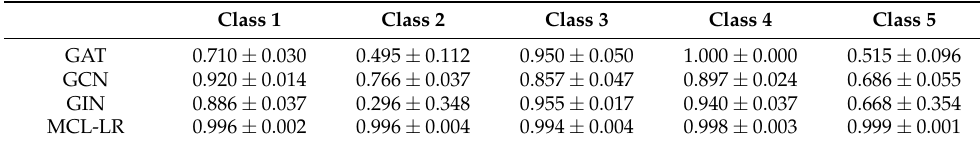
Table A1. Prediction accuracy for each class on the synthetic dataset.